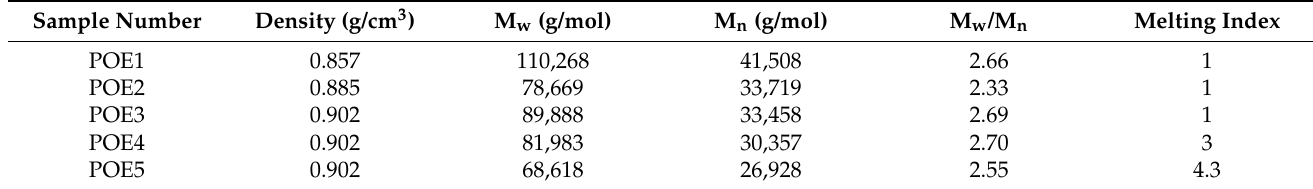
Table 1. Characteristics of the selected